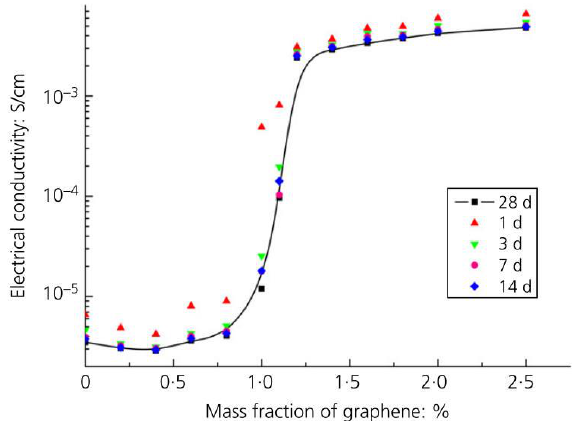
Figure 2. Variation of electrical conductivity of GRCCMs with graphene concentration. Reprinted with permission from Ref. [43]. Copyright 2020 Thmas Telford Ltd.